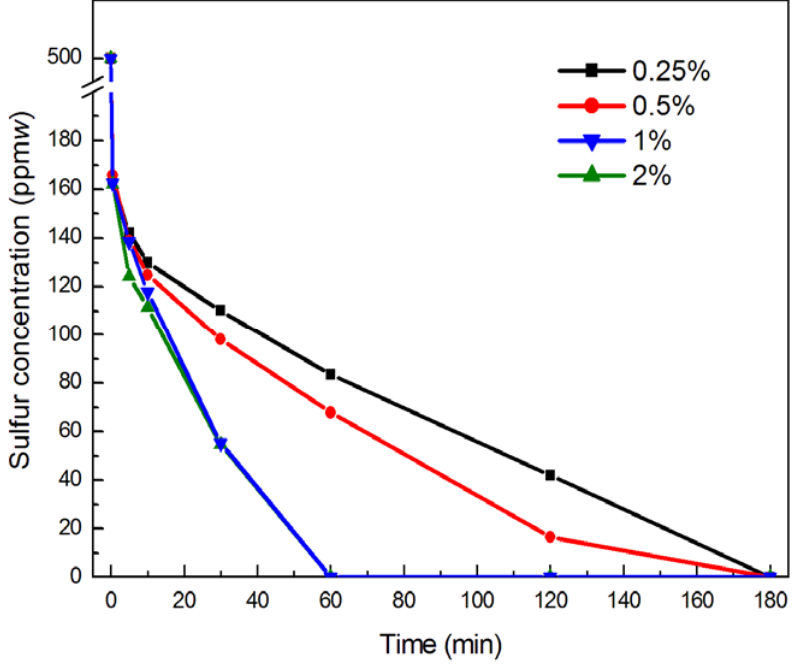
Figure 5. Effect of different amounts of catalyst on ODS of simulated oil. Experimental conditions: temperature 60 °C; O/S molar ratio 20; pre-reaction time 10 min; and DBT (S: 500 ppm( w ) in n